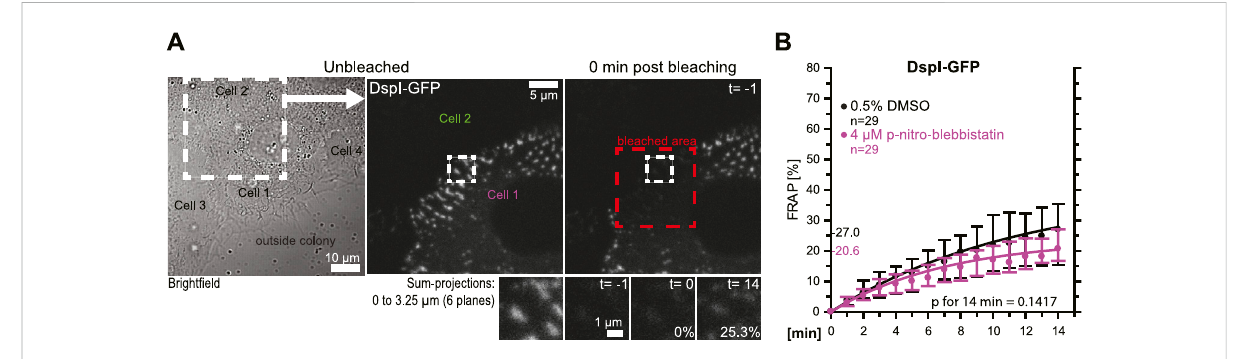
FIGURE 4 Desmosomes within a cell colony are only mildly affected by low dose myosin II inhibition. HaCaT cells were transfected with plasmids encoding fl uorescently tagged DspI (DspI-GFP). (A,B) The micrographs and graph show results of FRAP experiments, in which DspI was bleached in desmosomes that were located toward the center of the cell colony. The microscopy pictures present from left to right an overview bright- fi eld image and fl uorescence images corresponding to the marked area before and immediately after bleaching. The region of interest prior to, immediately after, 1 and 15 min after bleaching is depicted below. The graph shows the results of multiple measurements (same denotations as in Figure 3D).